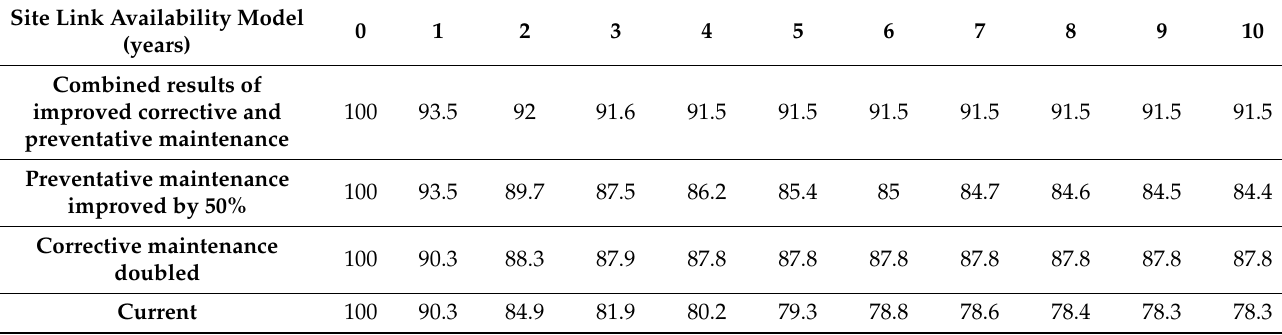
Figure 10. Results of the compared simulation of the site link. Table 4. Simulation results of site link availability.